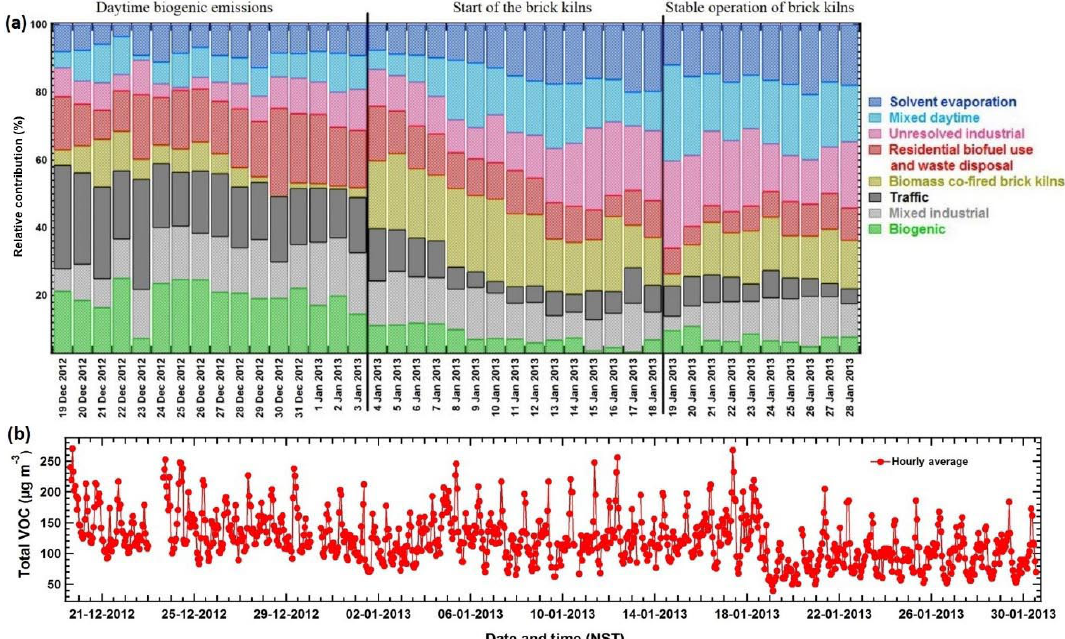
Figure 18. Daily mean relative contribution of the eight PMF-derived sources during the SusKat-ABC campaign